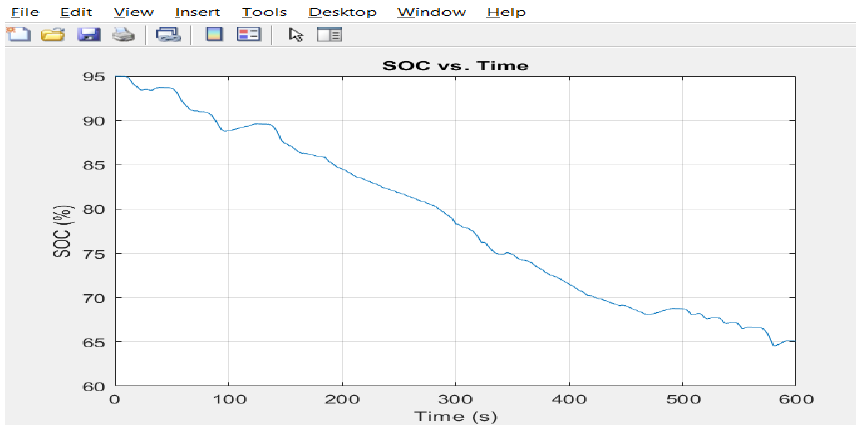
Figure 15. Battery’s State of Charge (SoC).